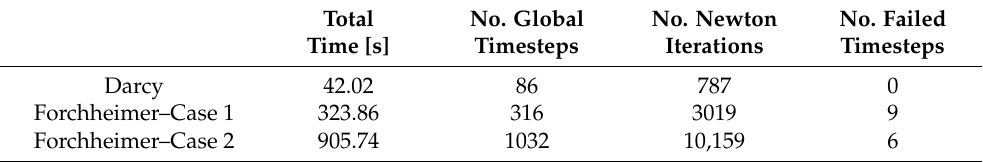
Table 5. Computational effort and numerical behavior for Scenario (b).